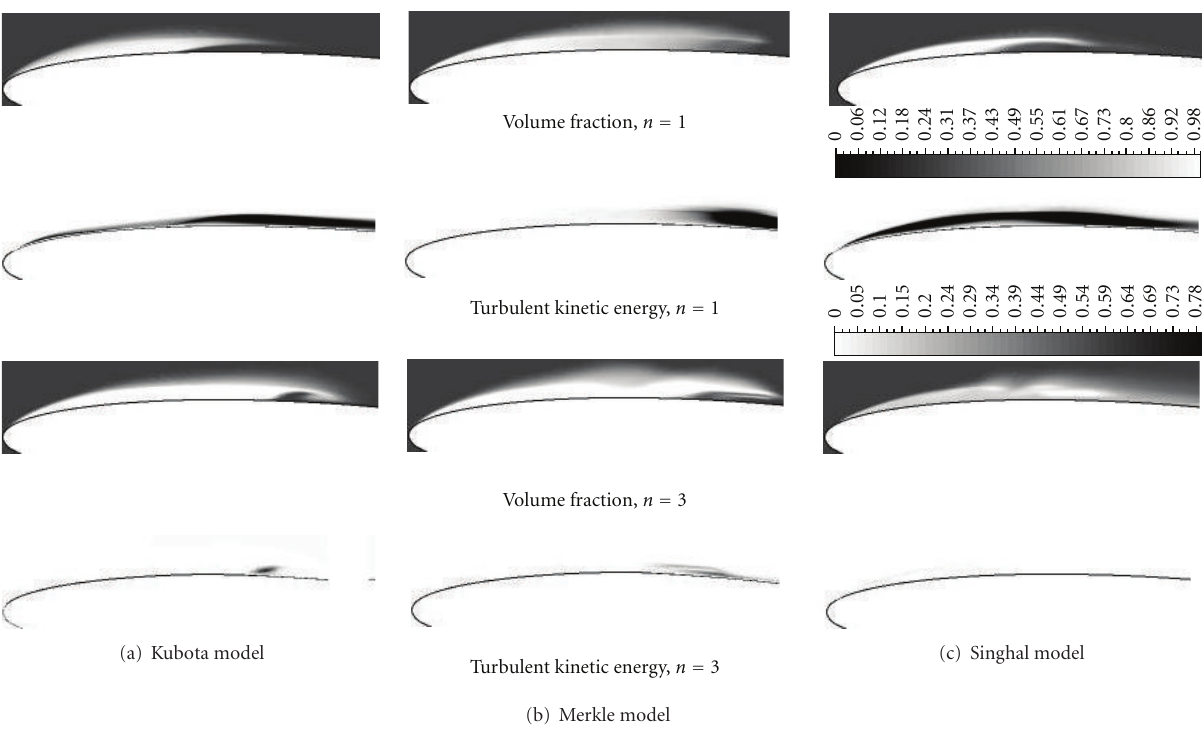
Figure 4: Comparisons of the vapor fraction and turbulence kinetic energy contours for the three di ff erent cavitation models with n = 1 and n = 3 for σ = 1 . 49, Re = 750,000, V ∞ = 5m/s, and α = 6 ◦